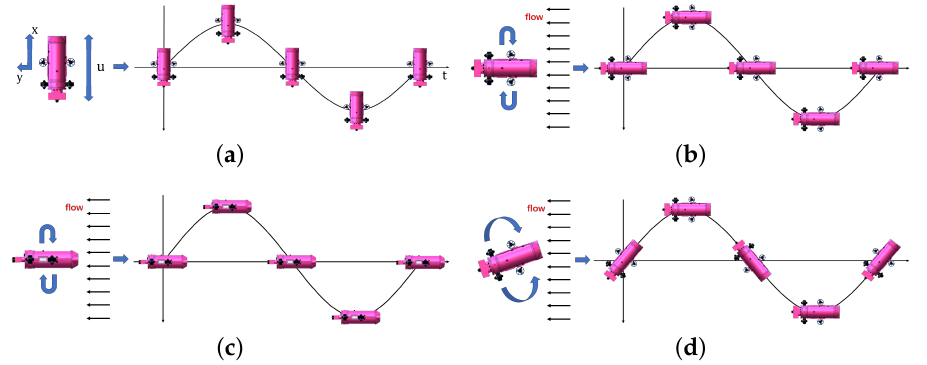
Figure 12. Schematics of four different unsteady motions of the underactuated underwater vehicle. ( a ) Pure surge motion; ( b ) pure sway motion; ( c ) pure heave motion; and ( d ) pure yaw